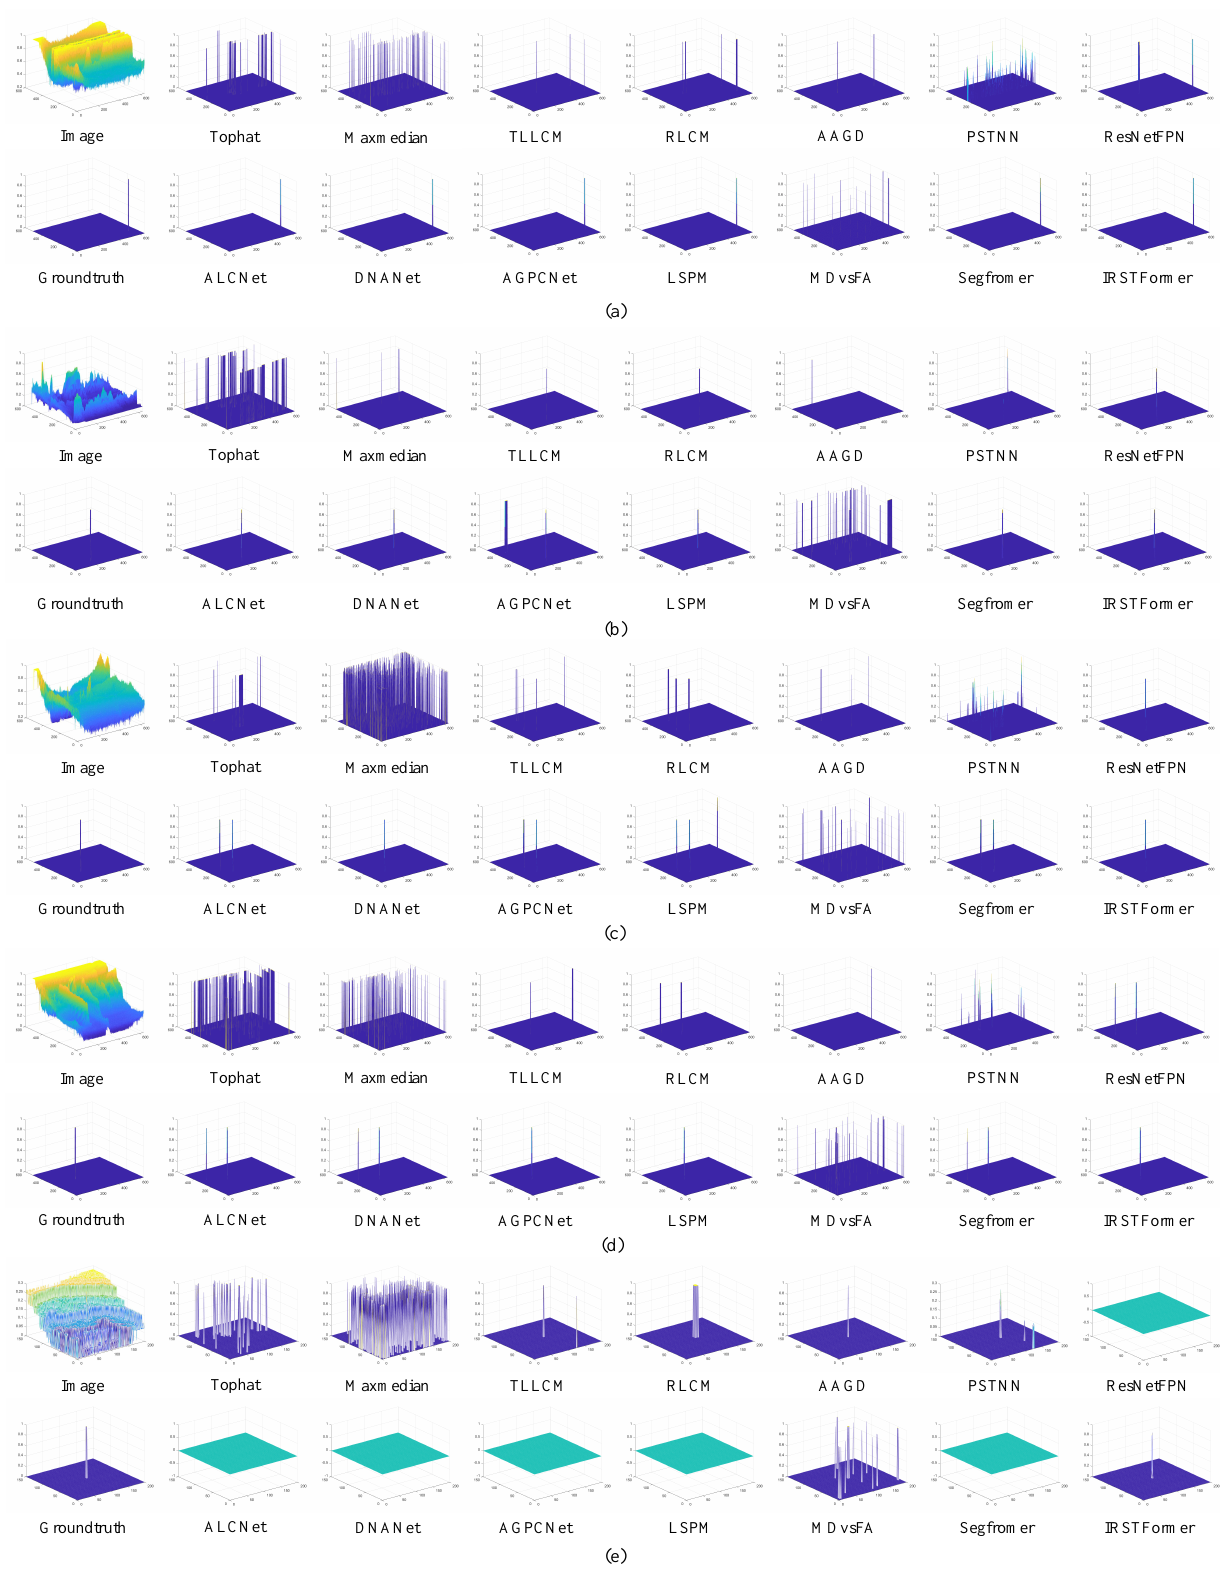
Figure 8. The 3D segmentation masks of 14 methods corresponding to the same image of cloud ( a ), ground ( b – d ), and noisy pixels ( e )